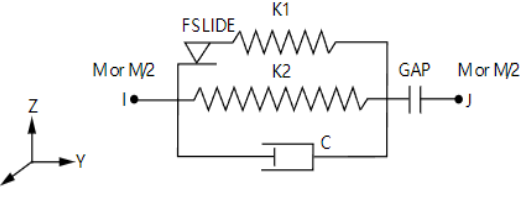
Figure 19. The mechanical principle of the diagram of Combin40 spring element.